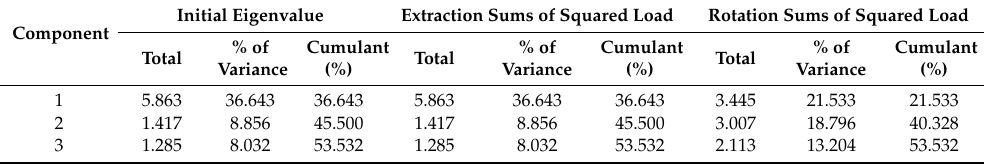
Table 2. Results of the factor